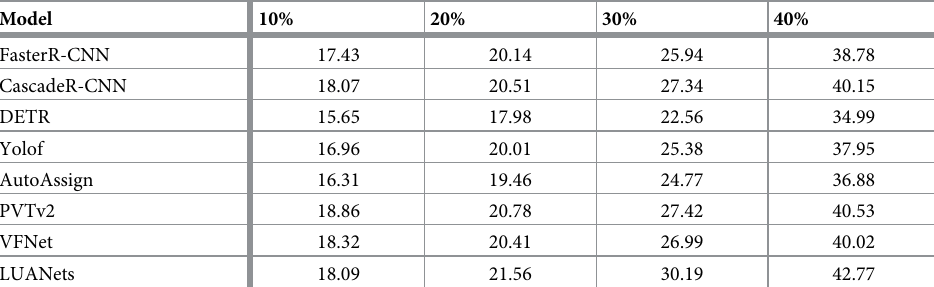
Table 3. Detection results of the different components.